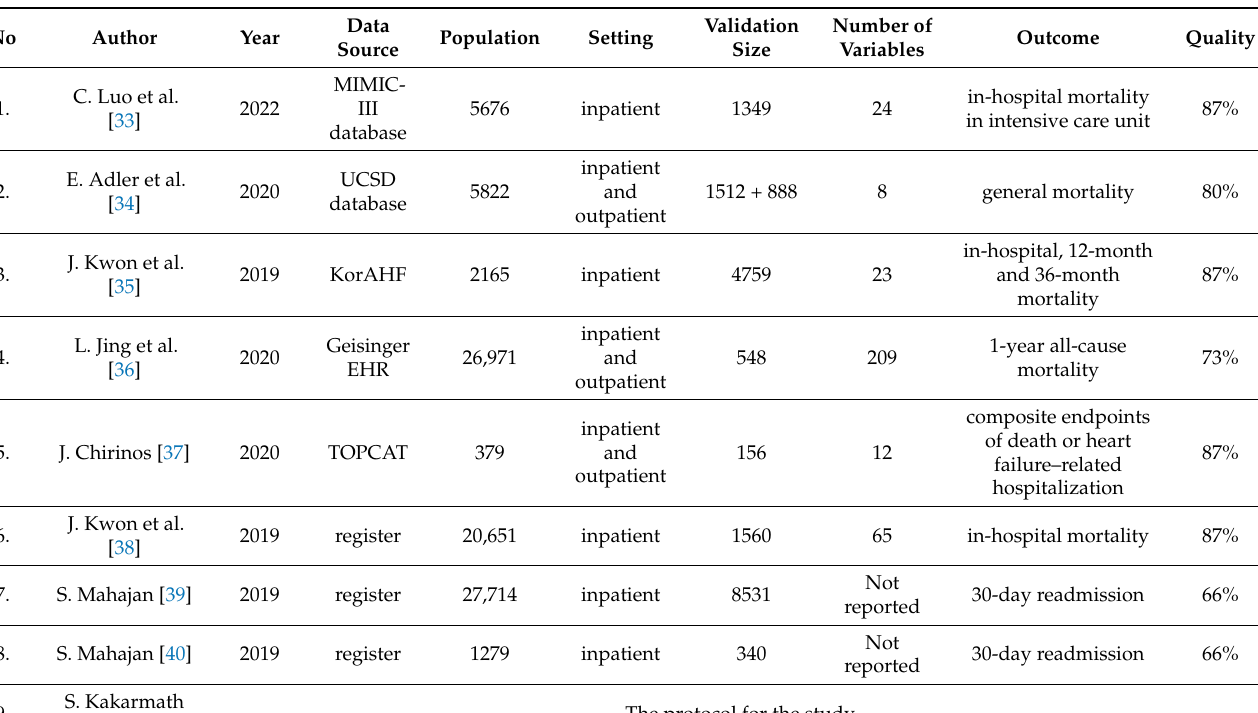
Table 2. Characteristic of included ML predictive models. MIMIC—Medical Information Mart